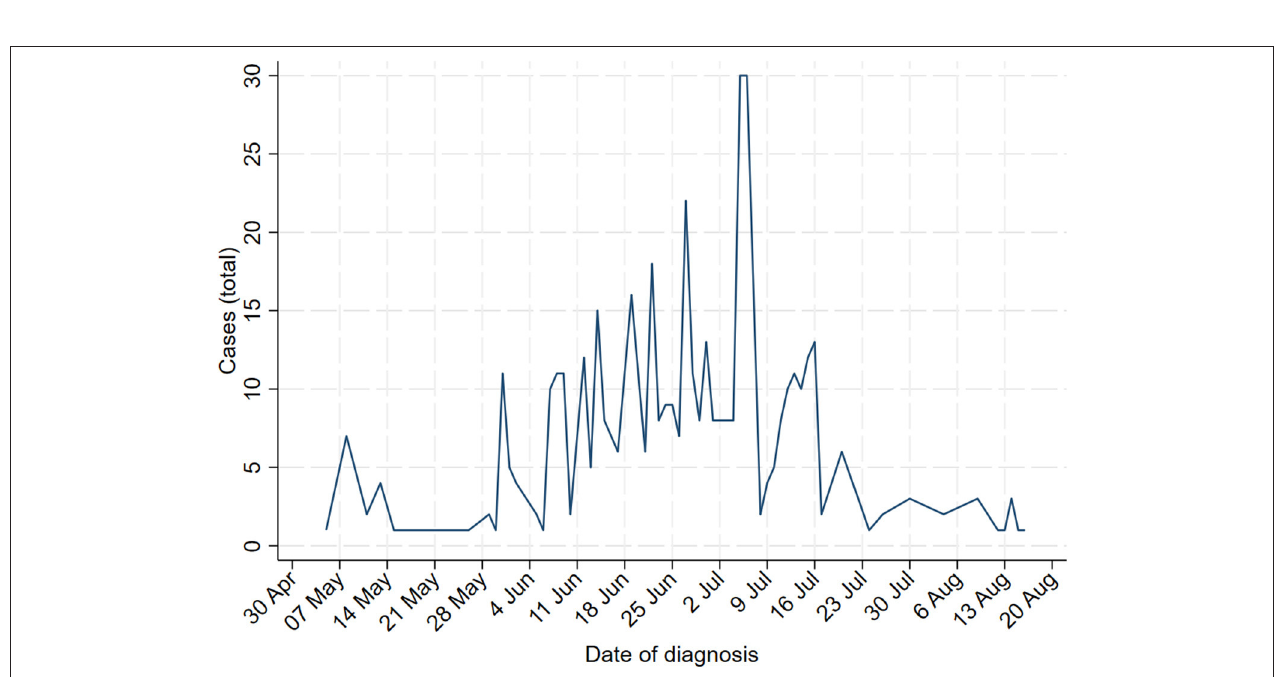
FIGURE 2 | Date of diagnosis of COVID-19 cases in Samtse